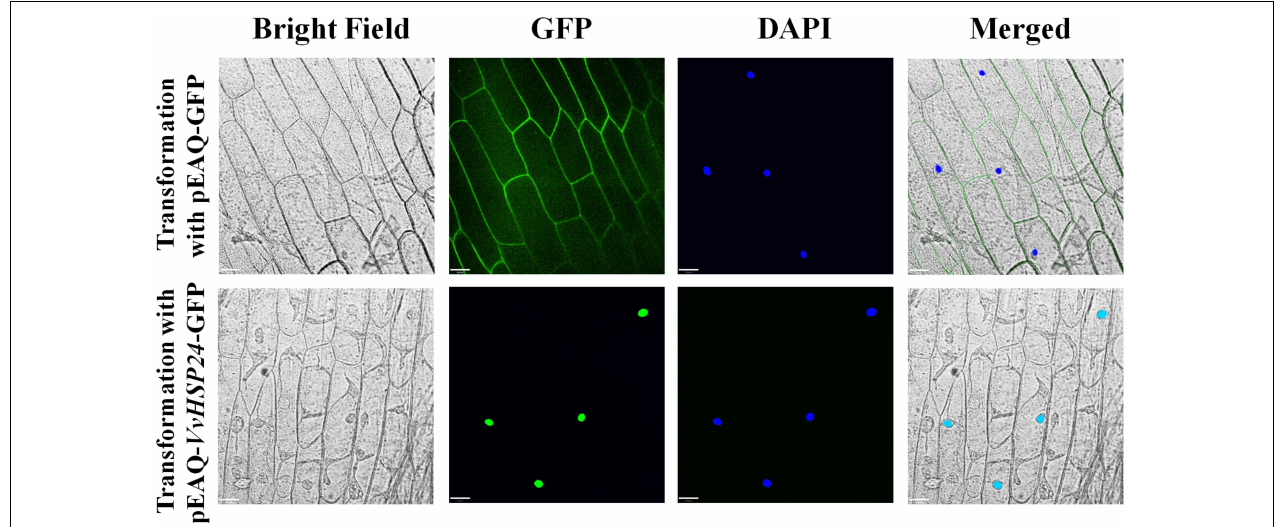
FIGURE 2 | Nuclear localization of pEAQ- VvHSP24 -GFP fusion protein. The fluorescence signals of pEAQ-GFP and pEAQ- VvHSP24 -GFP fusion protein were observed with onion peels after transformation by Agrobacterium tumefaciens . Nuclei were visualized by staining onion peels with 4,6-diamino-2-phenylindole (DAPI), and GFP signals were captured using LSM (bars = 70 µ